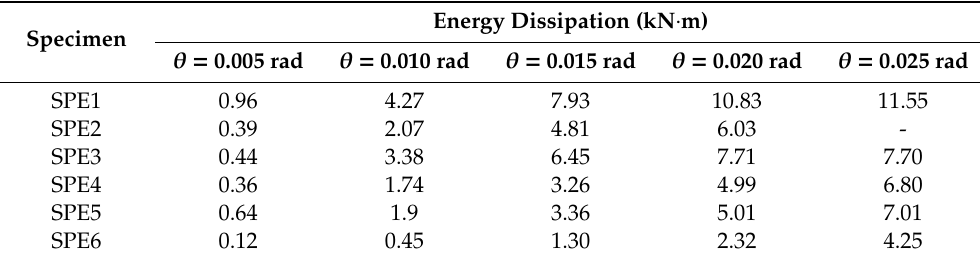
Table 8. Values of energy dissipation at main